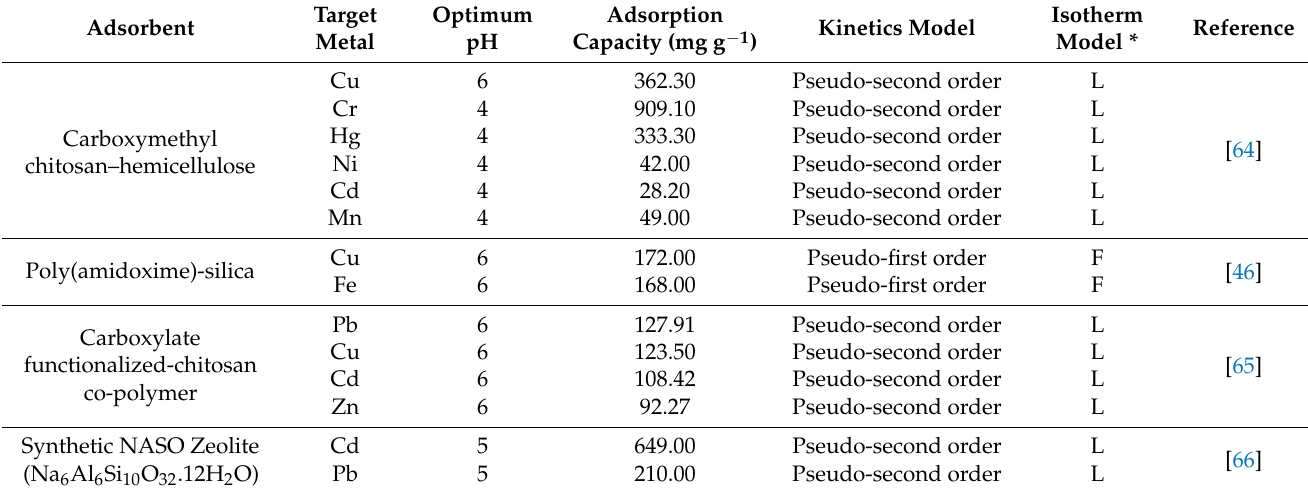
Table 12. Heavy metal adsorption capacities of various natural mineral-based